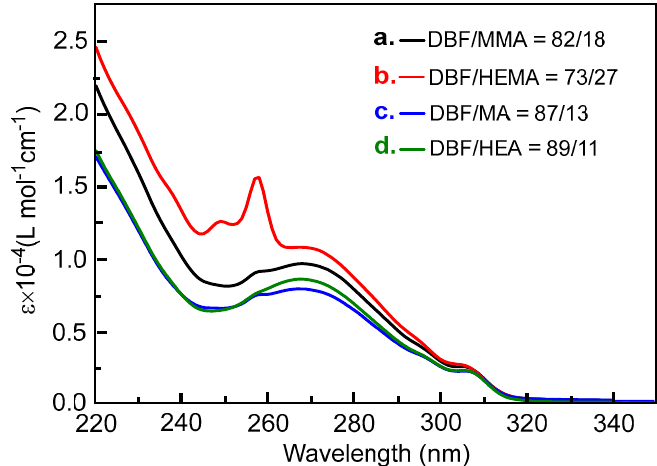
Figure 2. UV absorbance spectra of poly(DBF- co -MMA) ([DBF]/[MMA] in polymer = 82/18) (a), poly(DBF- co -HEMA) ([DBF]/[HEMA] in polymer = 73/27) (b), poly(DBF- co -MA) ([DBF]/[MA] in polymer = 87/13) (c), and poly(DBF- co -HEA) ([DBF]/[HEA] in polymer = 89/11) (d) ([DBF residue] = 0.94~1.15 × 10 − 5 M, THF, 1-cm cell, room